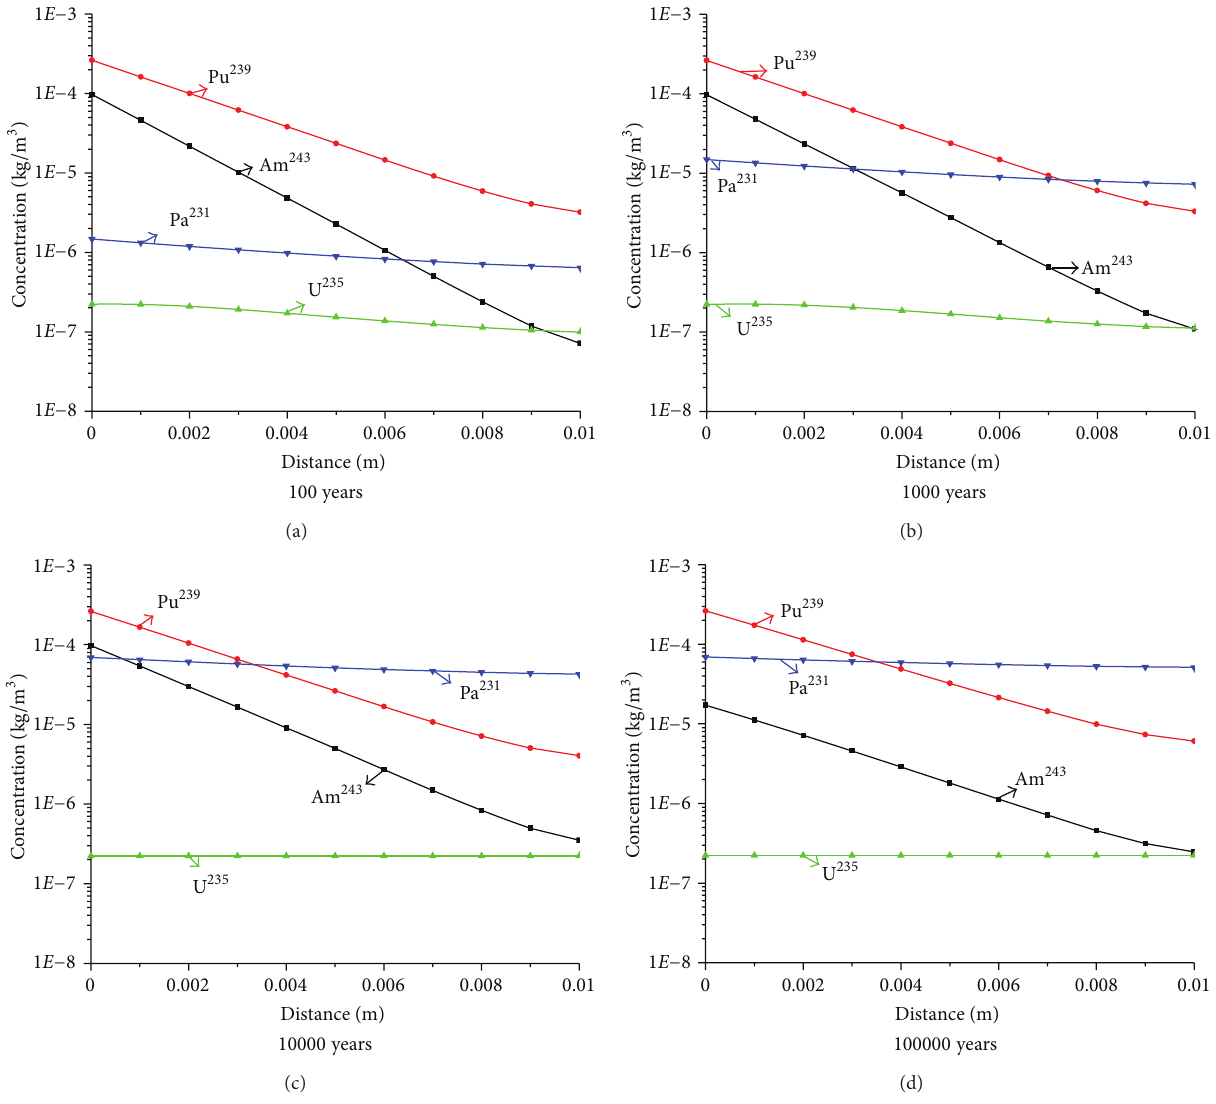
Figure 10: Concentration profiles in extruded bentonite region, for nuclides of 4 𝑛 + 3 chain (Am 243 → Pu 239 → U 235 → Pa 231 ) for 10 2 , 10 3 , 10 4 , and 10 5